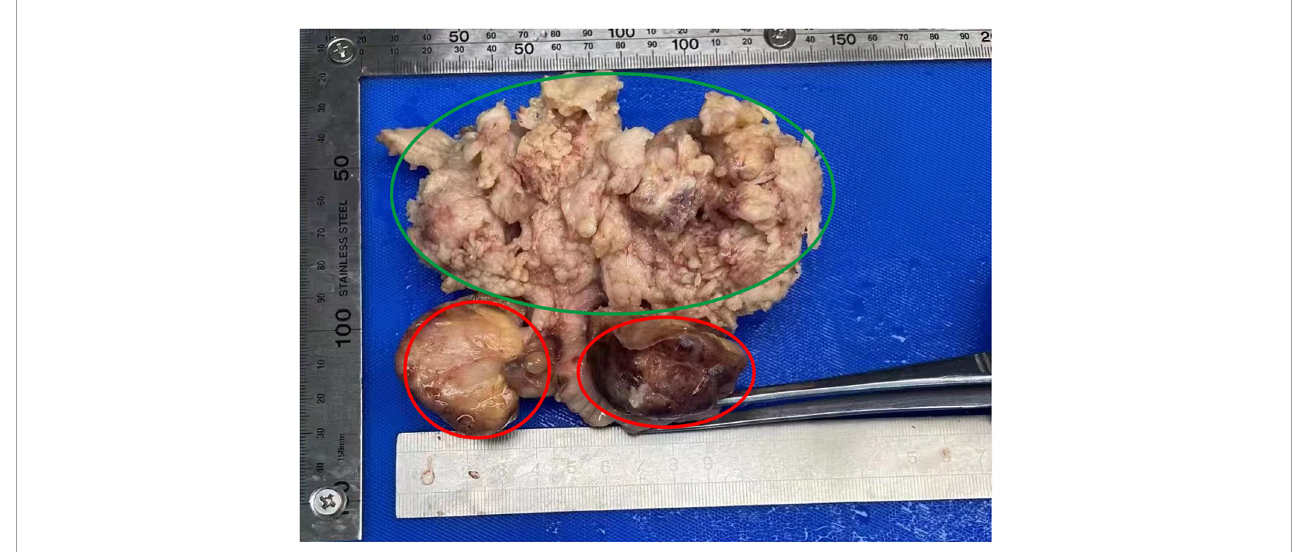
FIGURE1 Macroscopic appearance of the specimen indicating endometrial carcinoma of uterine corpus (green circle) and cervical carcinosarcoma (red circle).